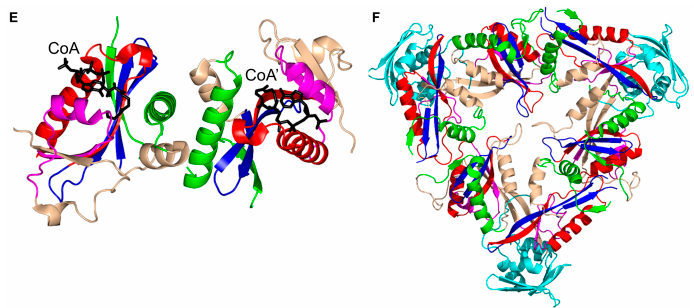
Figure 20. Representative oligomeric structures observed in the GNAT superfamily. ( A ) Monomeric ScMpr1; ( B ) dimeric StRimL where the β -strands from the two monomers at the dimer interface are arranged to form a continuous β -sheet; ( C ) dimeric interface where the C-terminal β -strands are interchanged between the monomers (ScGNA1); ( D ) a 12-strand β -barrel at the dimer interface of SmAAC(3)-Ia; ( E ) dimer interface involving α -helices from both monomers (hPCAF); and ( F ) one-half of the MtEis hexamer (two three-fold symmetrical trimers shown in this Figure assemble into an asymmetric “sandwich”). The conserved and non-conserved motifs of the GNAT domain, cofactors and substrates are colored as in Figure 3.